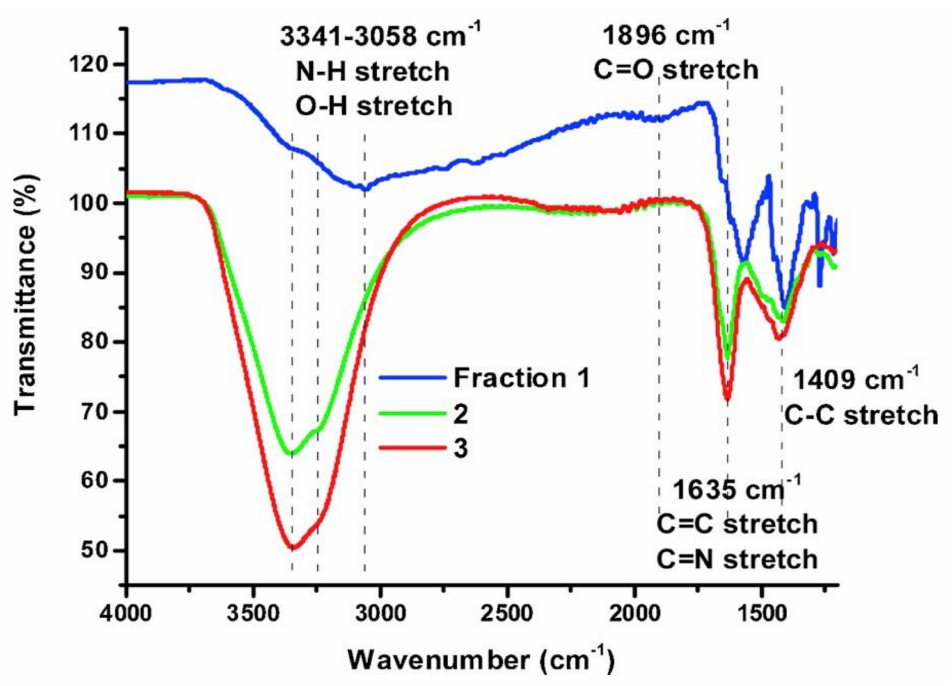
Figure 9. FTIR spectra of three CQDs fractions obtained from the same synthesis. Reprinted from ref. [114], with permission from